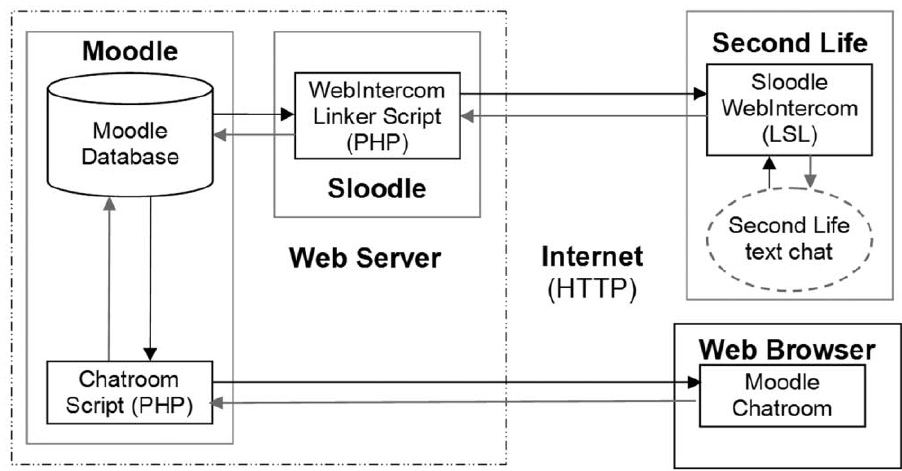
Figure 3. Sloodle is implemented using a mixture of PHP scripts residing on a Moodle server and LSL scripted objects in Second Life, as shown in this schematic of the web-intercom. Communica- tion between the two is via HTTP, the same protocol used by standard